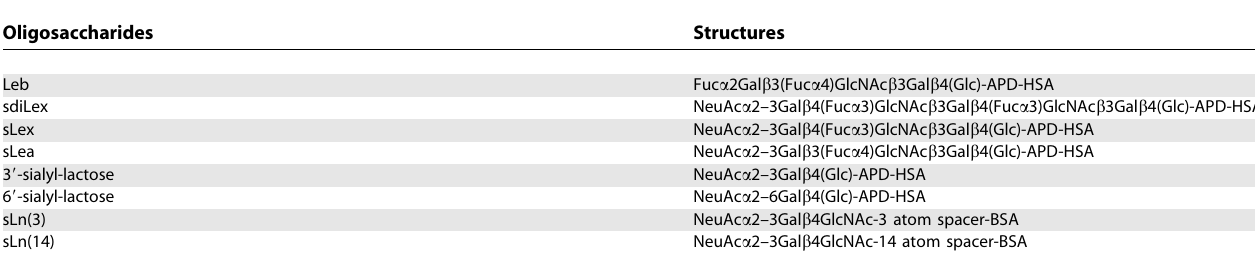
babA deletion mutant (J99 babA ) was not affected in sia-HA,